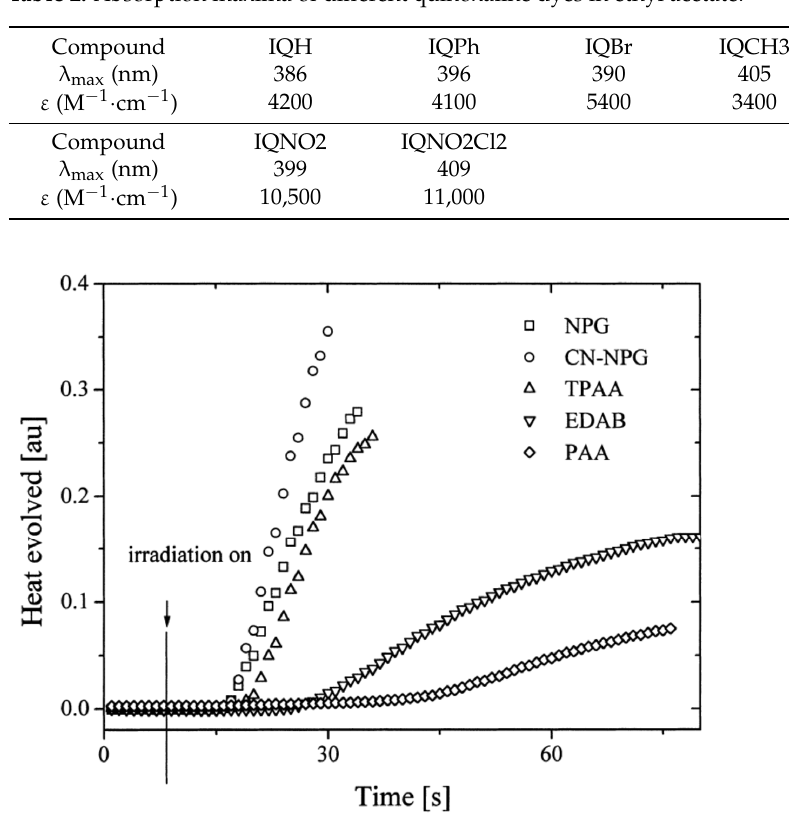
Figure 8. Polymerization profiles obtained by photo-DSC using IQCH3 as the dye and different electron donors (NPG, CN-NPG, TPAA, EDAB and PAA). Reprinted from Ref. [218] Copyright (2004), with permission from Elsevier.